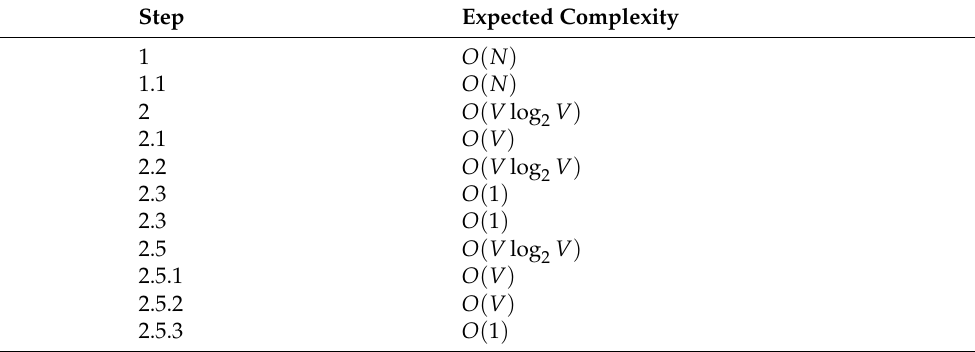
Table 1. The expected complexity by